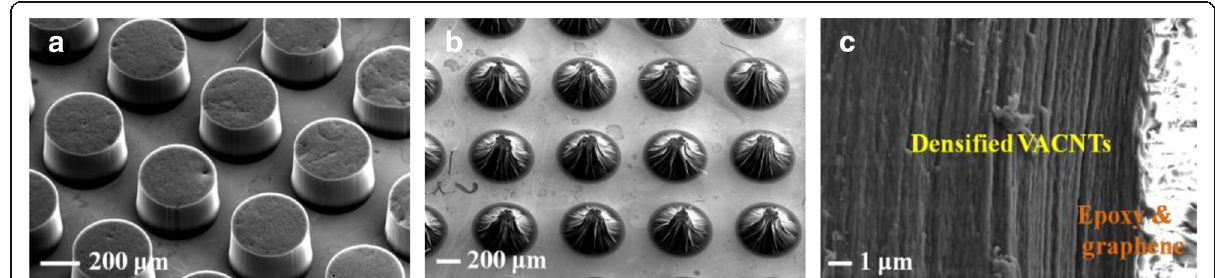
Fig. 7 a The SEM image of VACNTs with the patterned catalyst. b The SEM image of VACNTs after the densification. c The cross-sectional SEM image of the VACNTs/graphene composite film